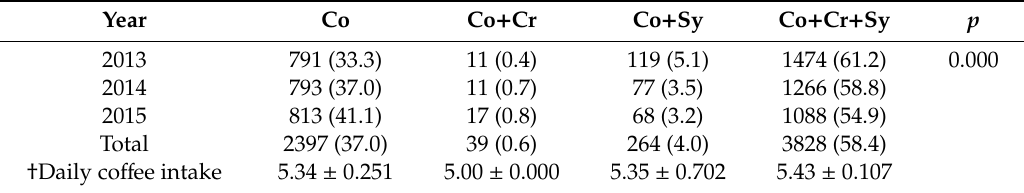
Table 1. Comparison of Co ff ee Components by Survey Year (Unit: N